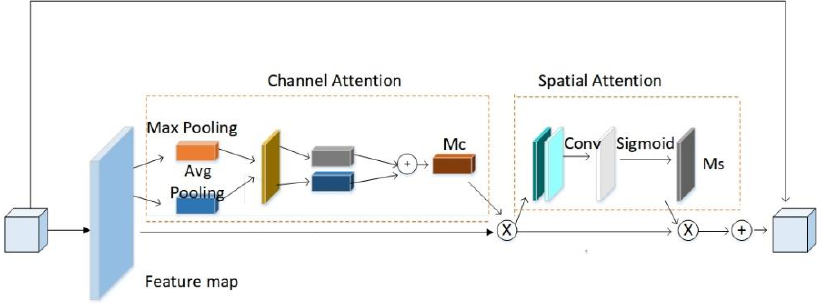
Figure 3. Embedding CBAM outside the convolution block. Figure 3 . Embedding CBAM outside the convolution block . Figure 3 . Embedding CBAM outside the convolution block .